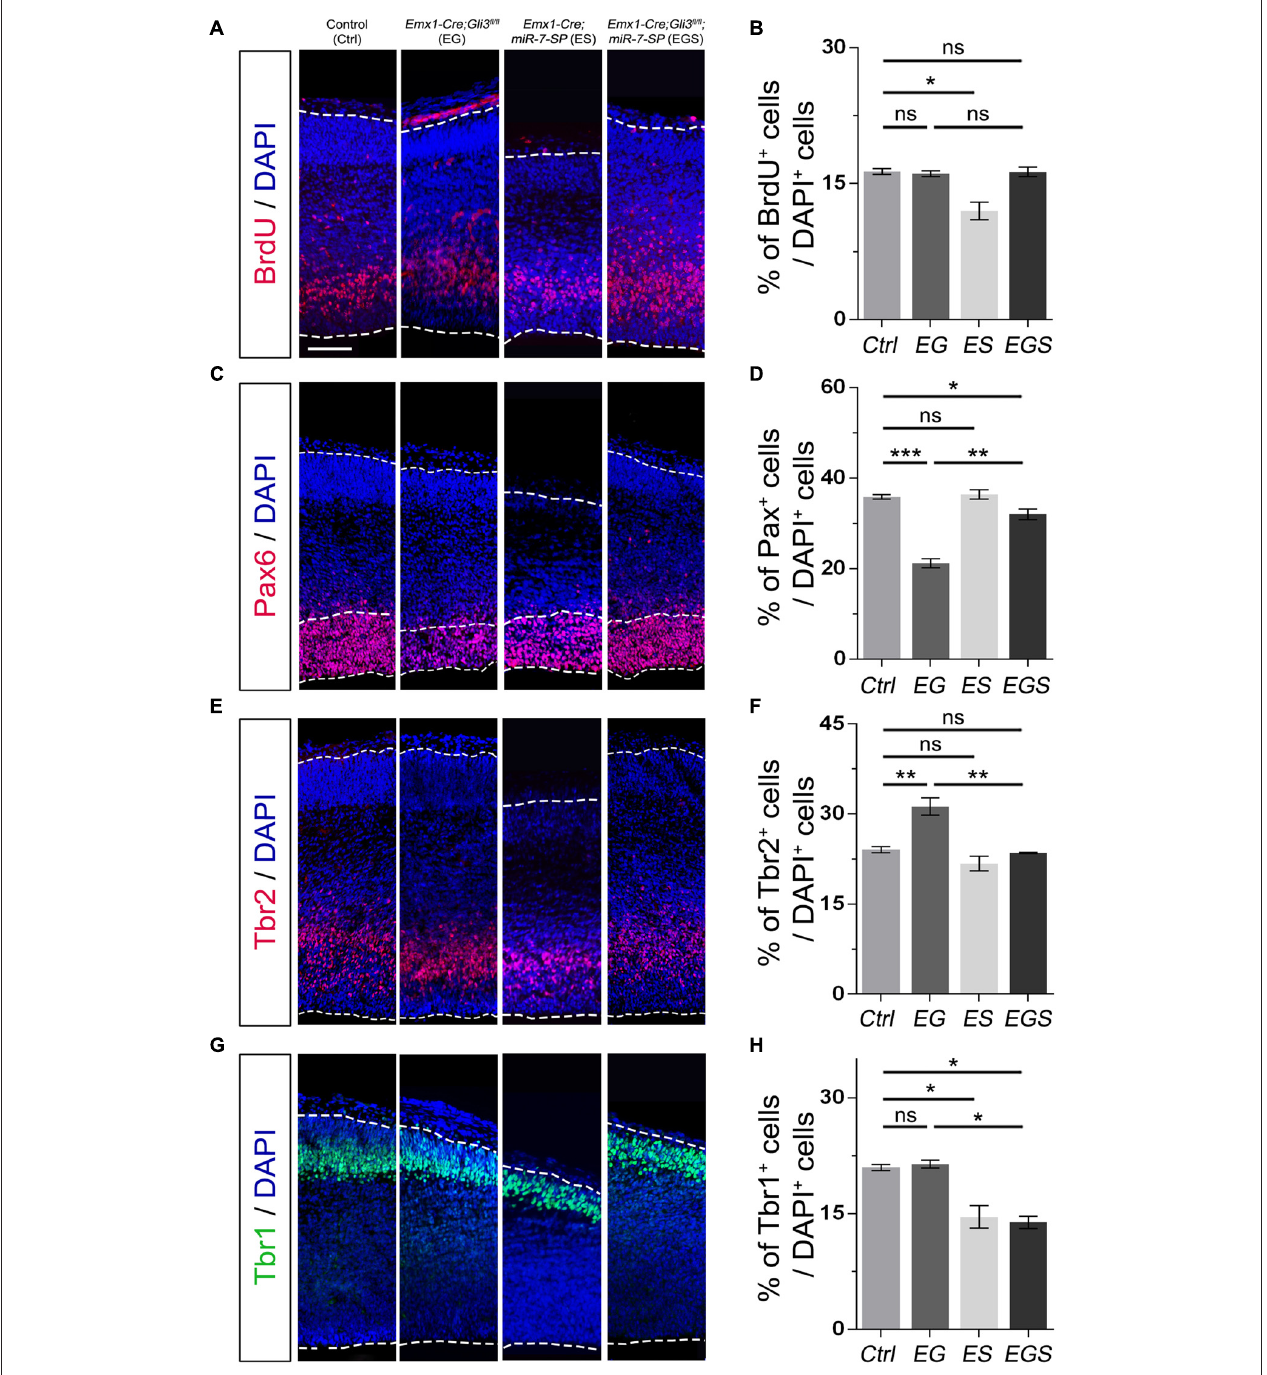
FIGURE 5 | Gli3 and miR-7 effects on the proliferation of NPs in the cerebral cortex. (A,B) Cortical deficiency of Gli3 did not have an impact on the proportion of BrdU + cells vs. DAPI + cells. Cortical deficiency of miR-7 decreased the proportion of BrdU + cells vs. DAPI + cells. (C,D) Cortical deficiency of Gli3 suppressed the population of cells expressing RGC marker Pax6 + /DAPI + , which was partially rescued by silencing miR-7. Silencing miR-7 showed no significant change of the proportion of cells expressing RGC marker Pax6 + /DAPI + at E15.5. (E,F) Losing Gli3 increased the ratio of IP marker Tbr2 + /DAPI + , which was restored by blocking miR-7. Knockdown of miR-7 did not affect the ratio of IP marker Tbr2 + /DAPI + . (G,H) No difference was observed in Tbr1 + cells vs. DAPI + cells in EG mice, which was significantly reduced by silencing miR-7. Cortical deficiency of miR-7 decreased the proportion of Tbr1 + cells vs. DAPI + cells. The markers BrdU, Pax6, Tbr2, Tbr1 and DAPI stained for proliferative NPs, RGCs, IPs, newborn neurons and all cells, respectively. Values represent mean ± SEM. n > 9. ∗ P < 0.05; ∗∗ P < 0.01; ∗∗∗ P < 0.001; ns, not significant. One-way ANOVA with post hoc test was used. Scale bar = 100 µ m.